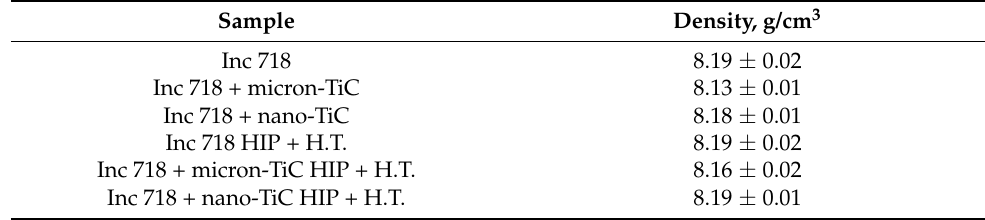
Table 5. Density of the fabricated samples.